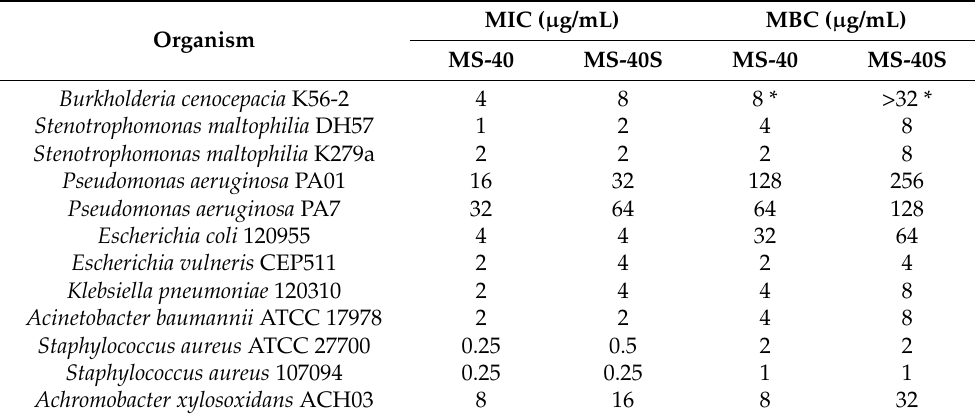
Table 3. MS-40S is bactericidal against other bacteria that infect CF patients.